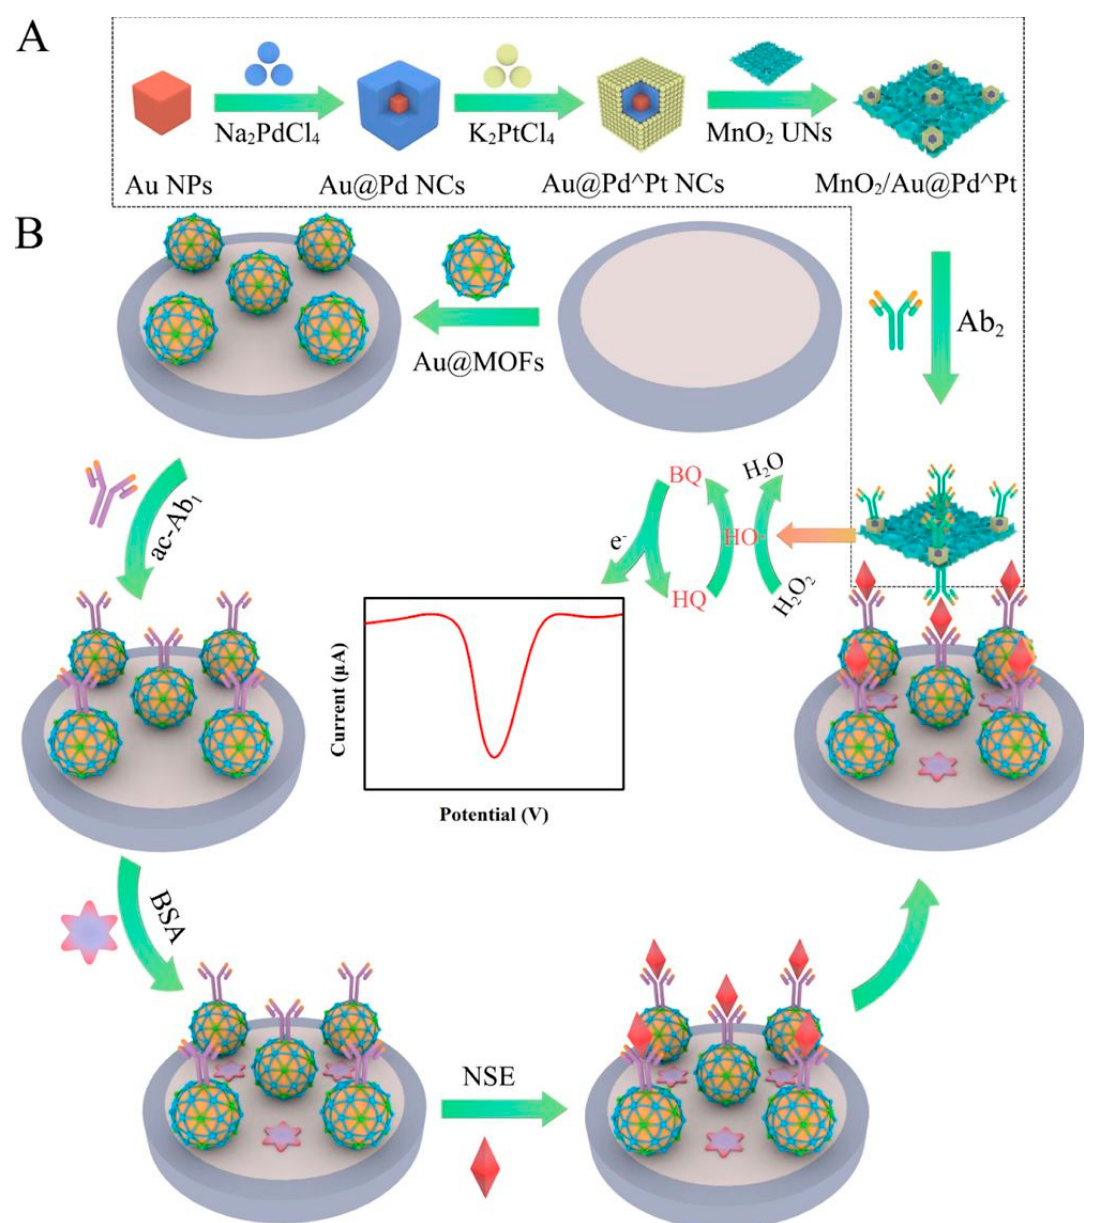
Figure 9. Electrochemical immuneosensor for neuron-specific enolase in blood serum. ( a ) A hybrid structure is formed using MnO 2 nanosheets decorated with trimetallic Au-Pt-Pd nanocubes and conjugated to a secondary antibody. ( b ) Glassy carbon electrodes are coated with antibodies-functionalized AuNPs-embedded MOFs and used as support for the targeting antibodies probes. This sandwich-like architecture increases the electrochemical efficacy upon binding to the target molecules. Image adapted from [81] with permission of American Chemical Society, 2020.